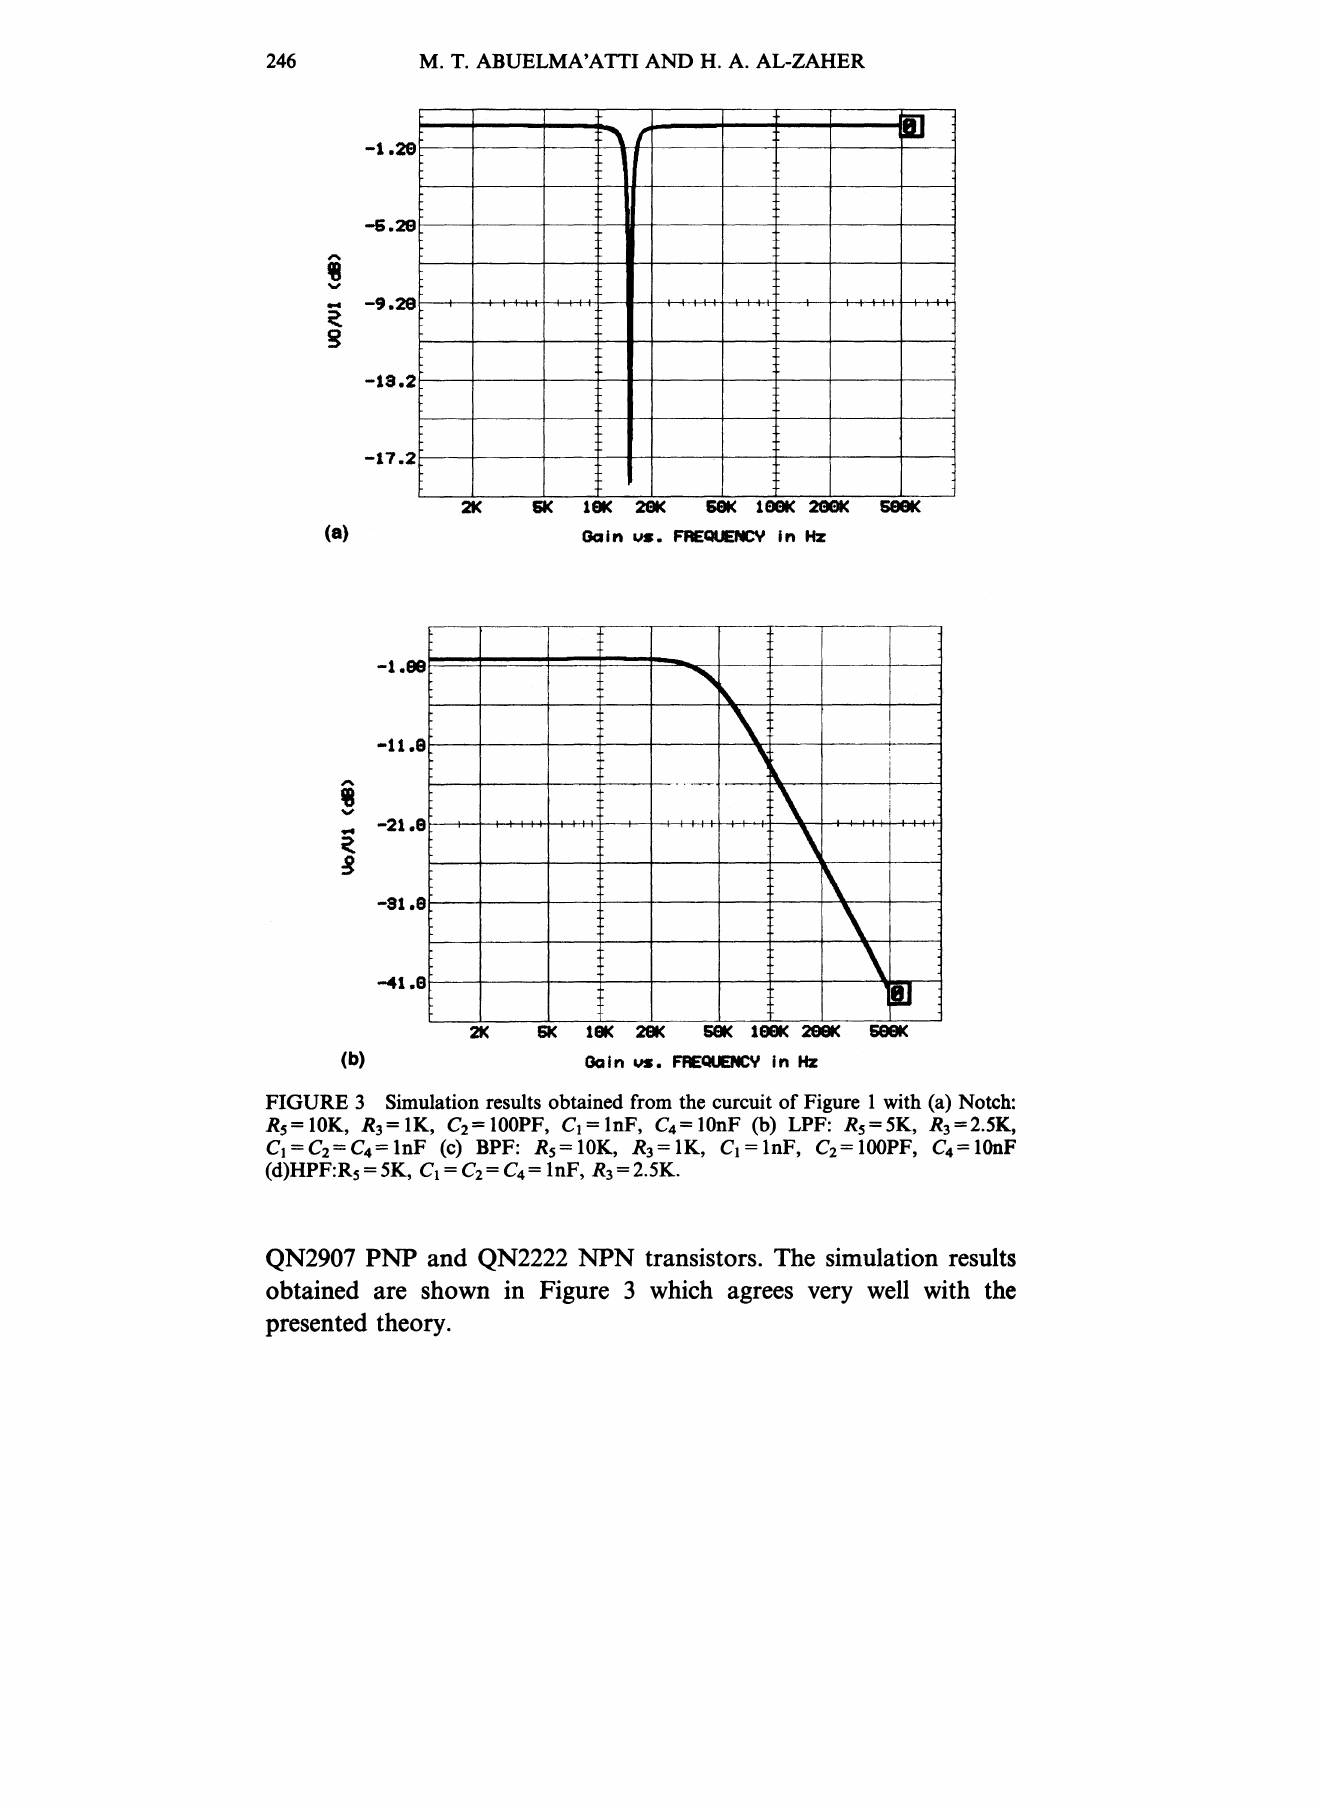
FIGURE 3 Simulation results obtained from the curcuit of Figure with (a) Notch: R5 10K, R3 1K, C2 100PF, C1 lnF, C4 10nF (b) LPF: R5 5K, R3 2.5K, C1 =C2=C4 lnF () BPF: R5 10K, R3 1K, C1 lnF, C2 100PF, C4 10nF (d)HPF:R5 5K, C1 C2 C4 lnF, R3